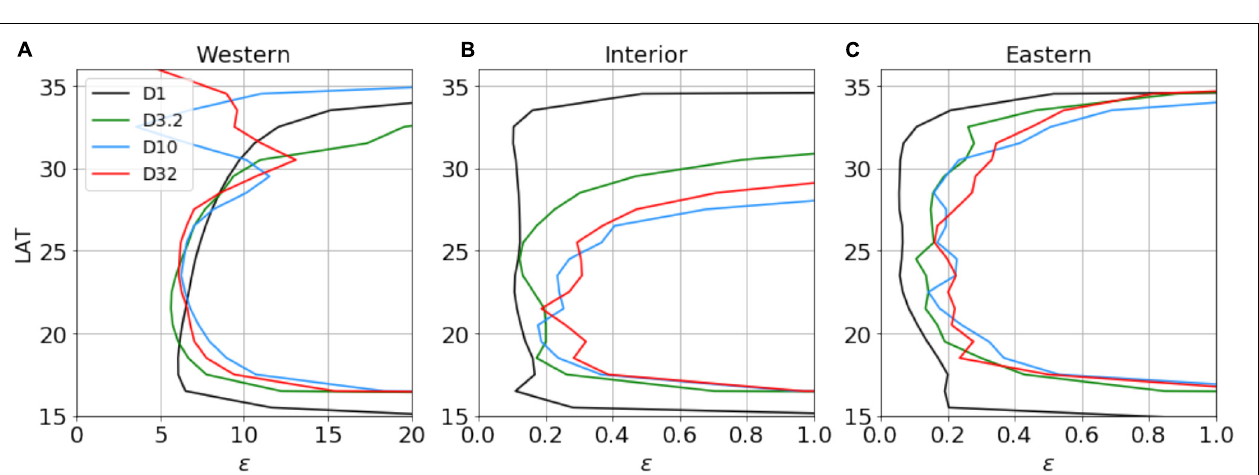
FIGURE 10 | Sverdrup domain (shaded) with the depth of the 26.5 isopycnal overlaid in red contours. The Sverdrup domain is defined by (Eq. 12) being smaller than 0.2. (A–D) Correspond to experiments D1, D3.2, D10, and D32, respectively.